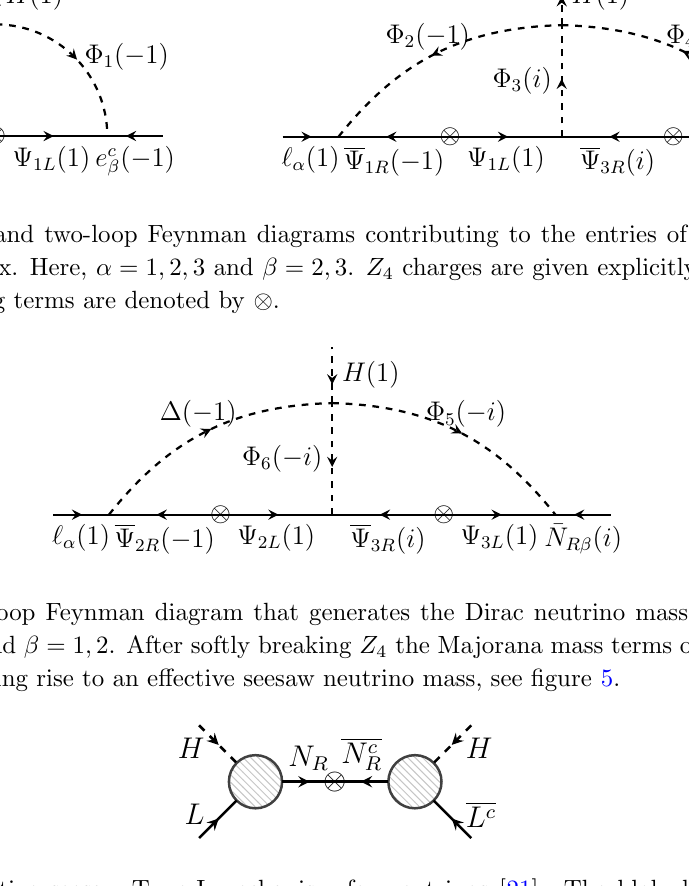
indicates the (cid:10)